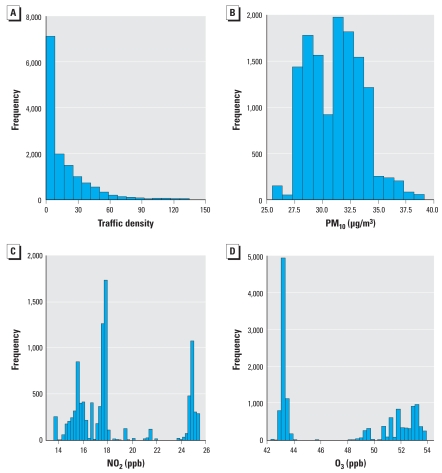
Distribution of traffic density at ARIC participant residences (1987–1989). (A) Traffic density (n = 13,309). (B) PM10 ( μg/m3; n = 13,309). (C) NO2 (ppb; n = 9,902). (D) O3 (ppb; n = 13,309).